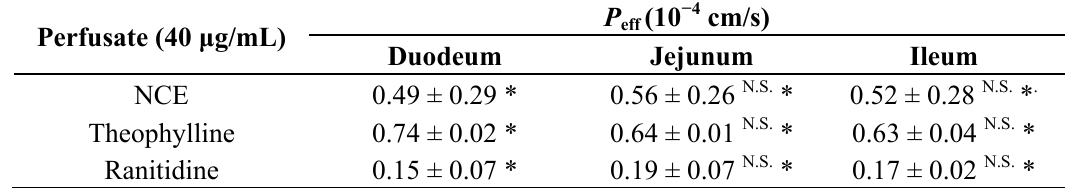
Table 4. Effective permeability of NCE, theophylline and ranitidine using single-pass intestinal perfusion method. The data were presented as mean ± SD ( n = 6 for each